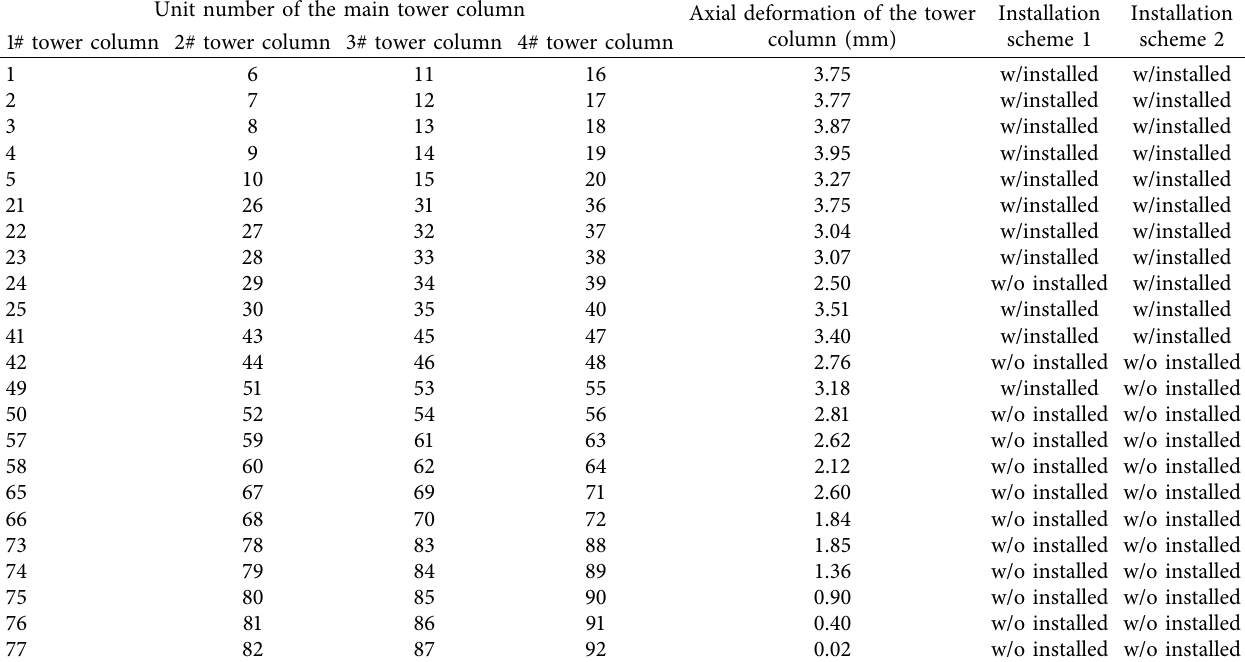
Table 3: Installation scheme of VEDs.